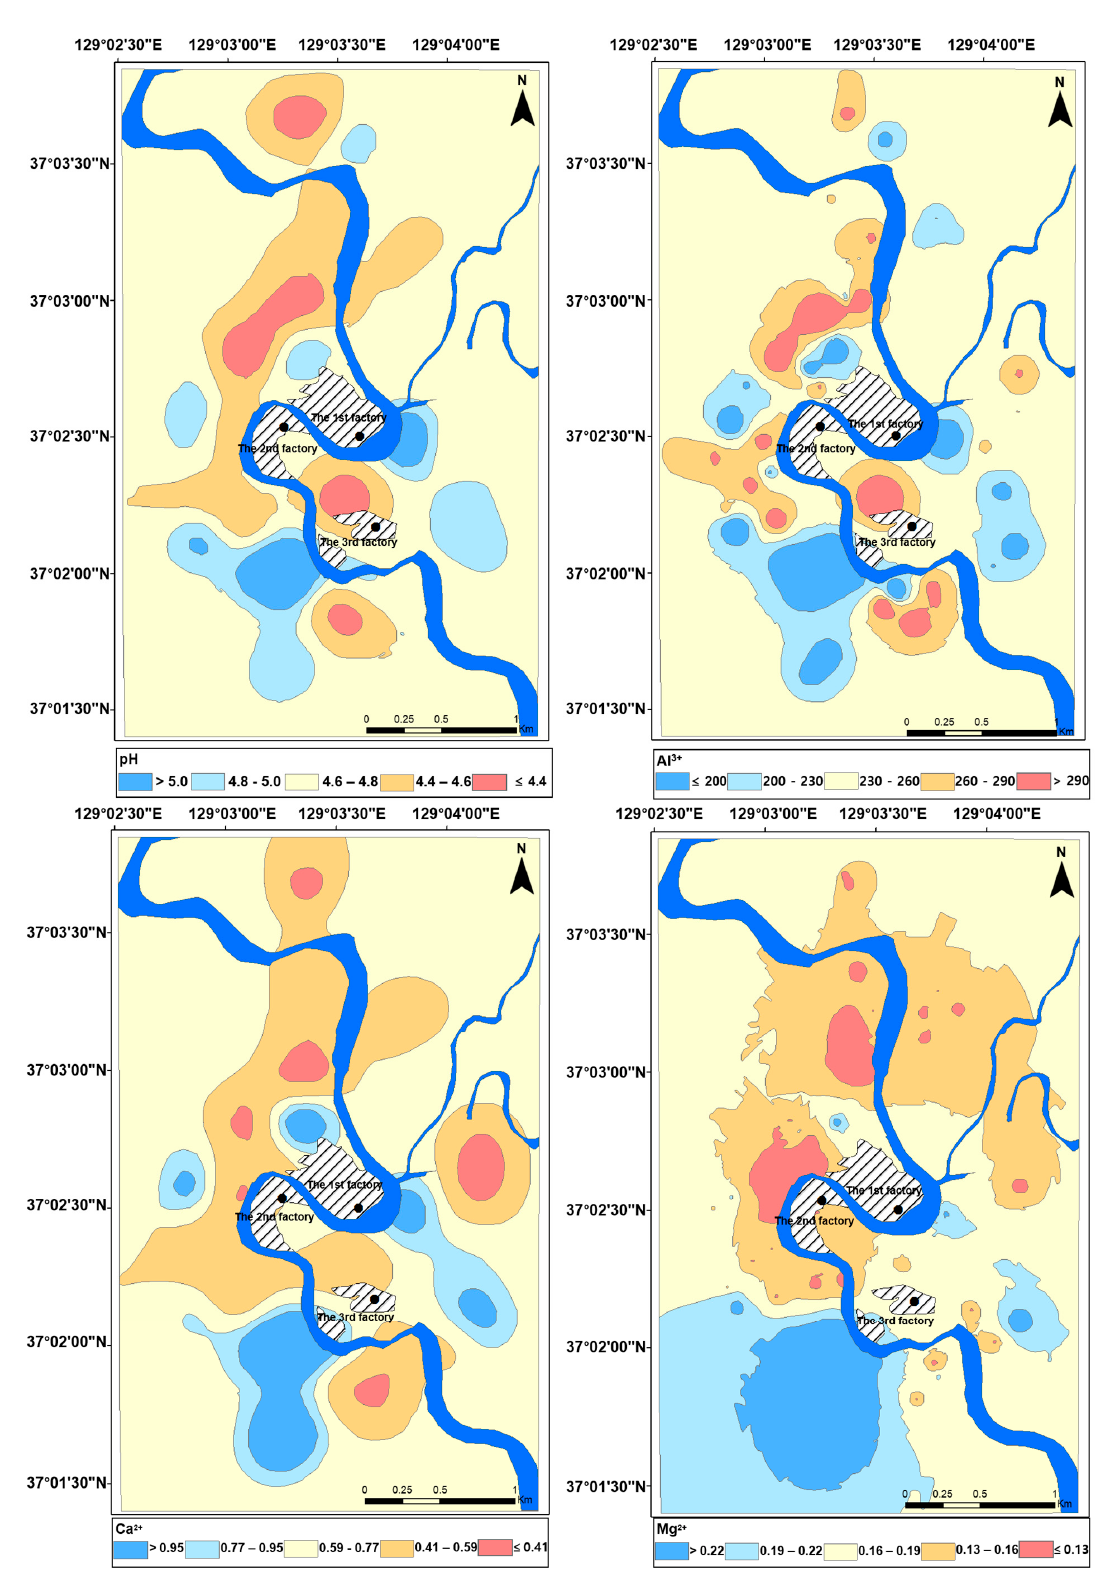
Figure 6. Spatial distribution of soil pH and Ca 2+ , Mg 2+ , and Al 3+ contents of soil in the study area.